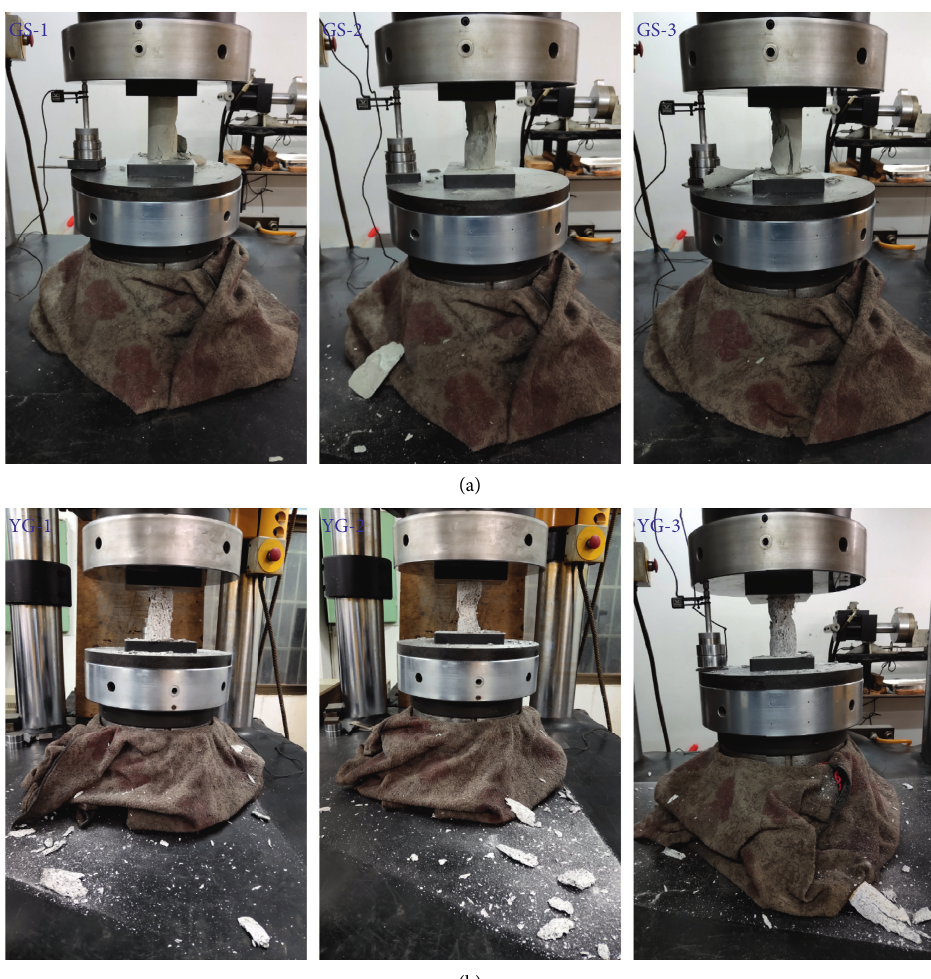
Figure 12: Ejection characteristics of rock specimens in cyclic loading-unloading test of (a) Green sandstone and (b) Yueyang granite.